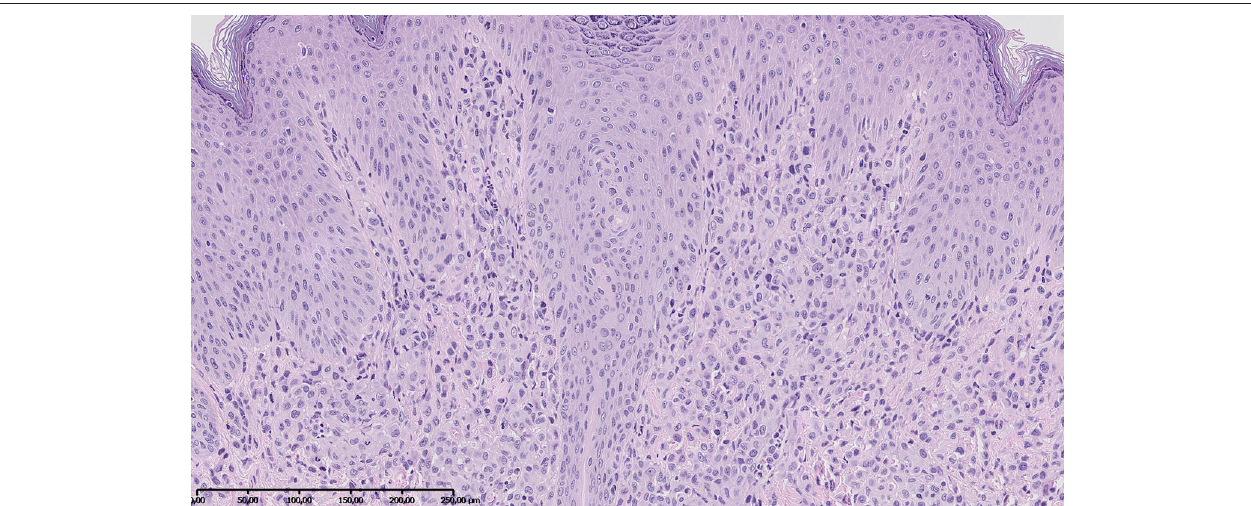
FIGURE 4 | Skin biopsy revealed diffuse infiltration by histiocytes positive for CD45 and CD68 and negative for S100 and CD1a. Hematoxylin–eosin stain; magnification, × 10.